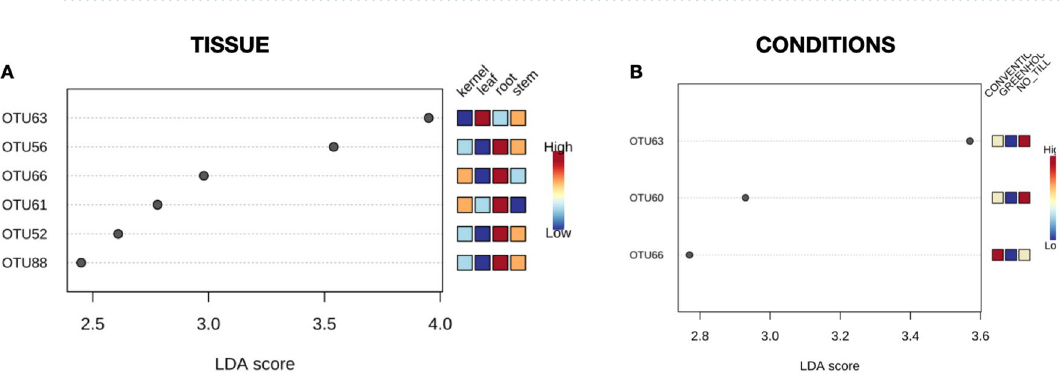
Figure 4. OTU with significant differential abundance regarding ( A ) wheat tissues and ( B ) growth conditions, created by Linear Discriminant Analysis Effect Size (LEfSe). The heat maps indicate the OTU abundance in each